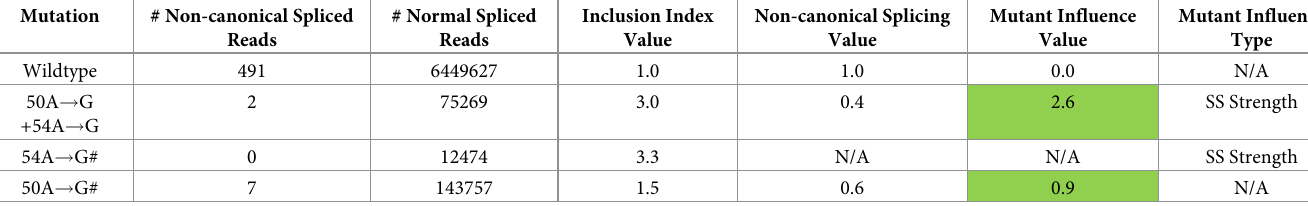
Mutant Influence Values are shaded green if the mutation selectively induces canonical splice site usage, white for no splice site preference and the red for non-